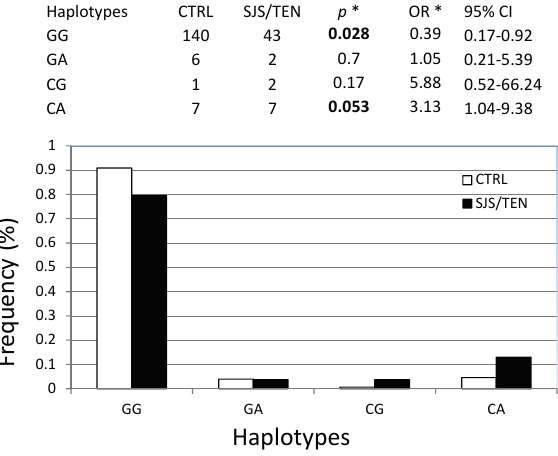
Figure 1. Rs76228616 (G>C)–rs33980500 (G>A) haplotypes distribution in cases and controls. * Each haplotype has been compared vs. the sum of the others. Significant p values are reported in